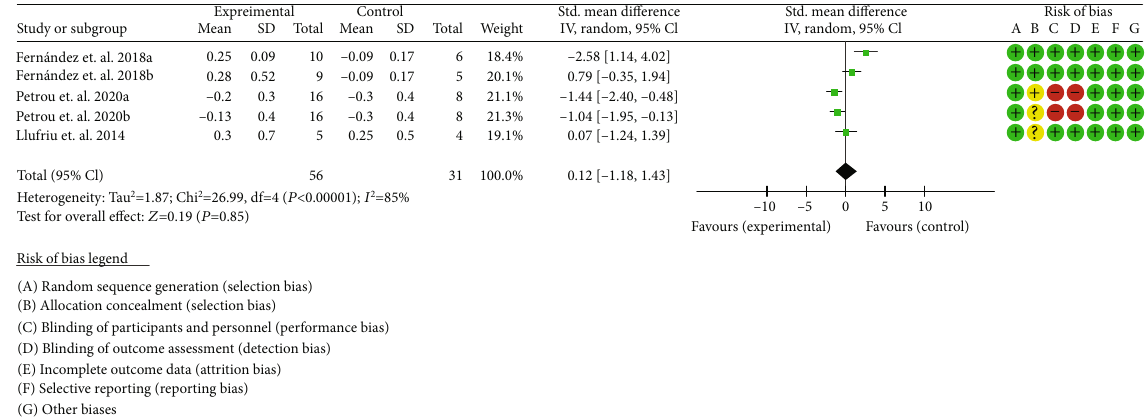
Figure 12: Expanded disability status scale (CI: con fi dence